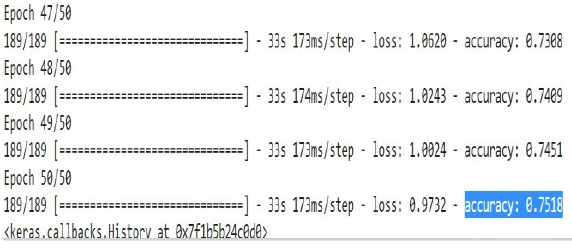
Fig. 6. Corresponding Accuracy and Loss of the trained model at Epoch value 50